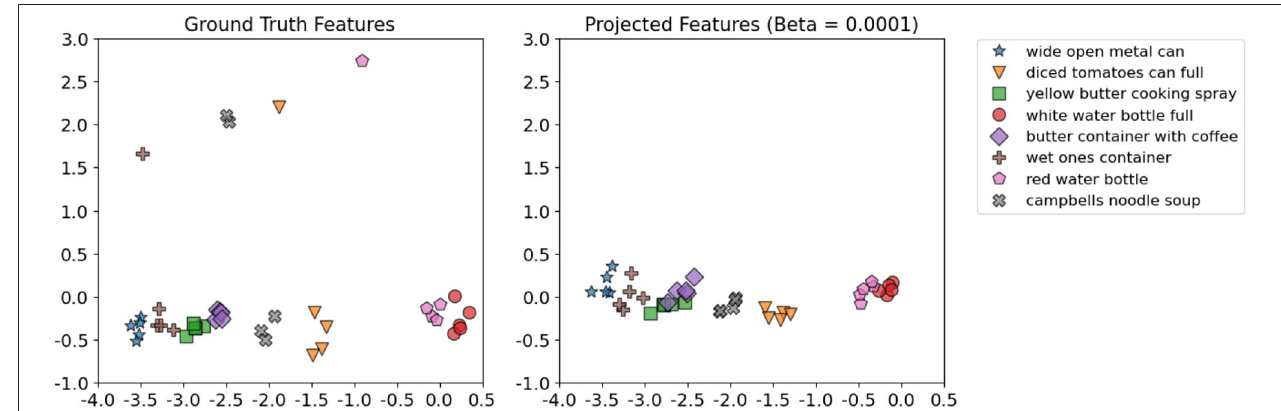
FIGURE 21 | 2D visualizations using Principal Component Analysis of the target robot’s lower-haptic ground truth features and β -VED projected features’ (from lift-haptic ) for the dataset in Sinapov et al.